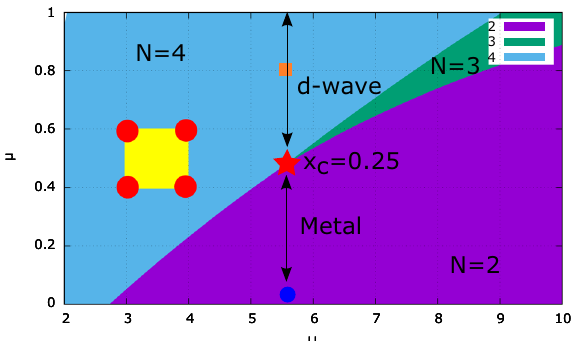
Fig. 1 Plaquette ground state. Phase diagram of 2 × 2 plaquette for different particle sectors ( N = 2, 3, 4) and zero temperature with the degenerate point marked by star. The circle and and square display the shifted chemical potentials for a test comparison. The region of d x 2 (cid:1) y 2 superconducting phase and normal metal for square lattice are also marked.